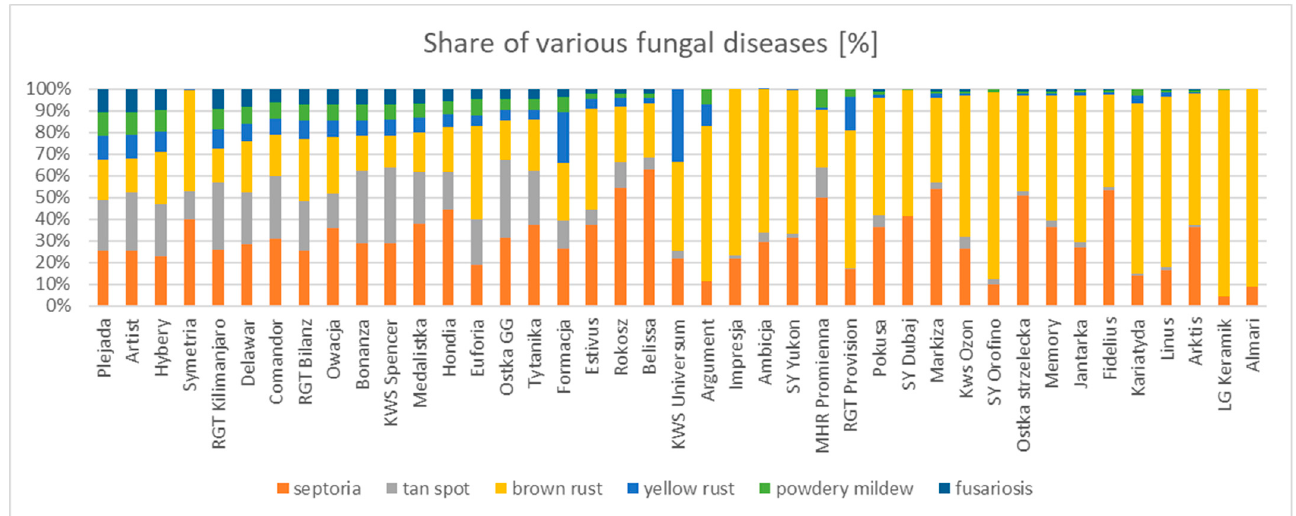
Figure 4. Share of individual diseases in the pool of total infestation on the tested varieties. The most resistant varieties have been placed on the left side of the graph, the most susceptible on the right.